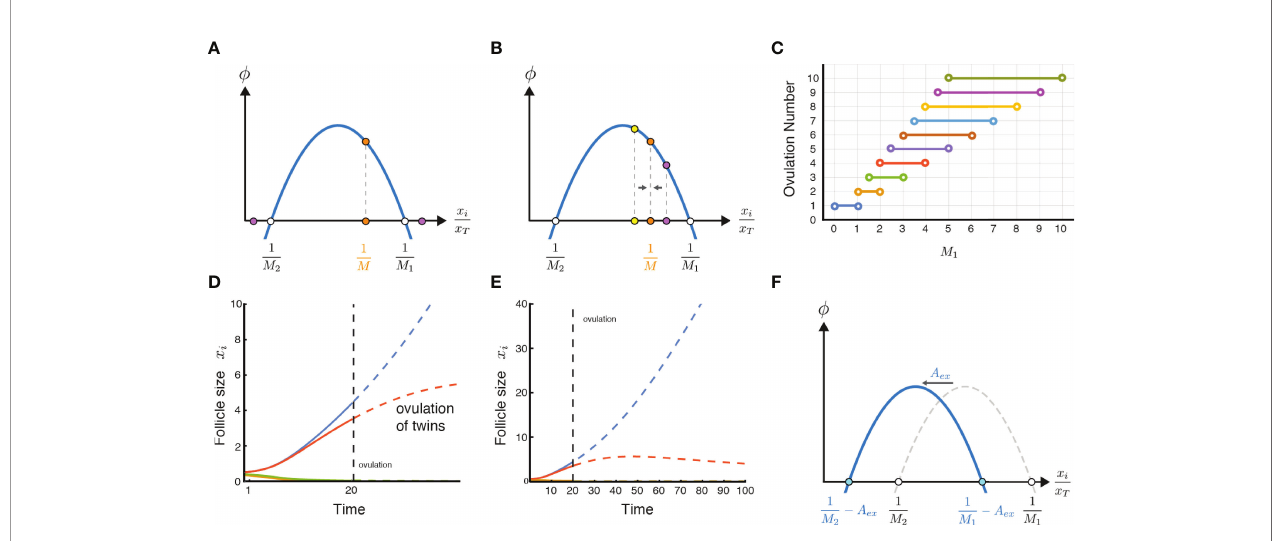
FIGURE 3 | Ovulation number stability, twin ovulations, and the effect of excessive circulating androgen. (A) A stable solution of ovulating follicles should satisfy M 1 < M < M max , thus 1 M is in the positive declining part of f . (B) An intuitive but imprecise explanation for the criteria for the stable solution is that in the declining part of f , deviations 1 from the symmetric solution converge back to it, and thus the solution is stable. (C) Ovulation numbers as a function of M 1 in the limit of M 2 >> M 1 . When ovulation of one follicle is a possible ovulation number, it is the only stable solution. (D) A twin ovulation can occur even when M = 1 is the only stable solution, when two follicles start with a similar size and ovulate together near an unstable solution when high enough estrogen triggers the LH surge. Parameters: M 1 = 0.5, M 2 = 4, ovulation occurs when x T ( t ) = 4.6 x T (0) (38)(SI section 2). (E) Same simulation as in D continued to later times (without allowing ovulation), showing that the smaller dominant follicle eventually shrinks. (F) Excessive or exogenous androgen, A ex , shifts the parabola to the left, effectively changing the values of M 1 and M 2 and potentially disrupting